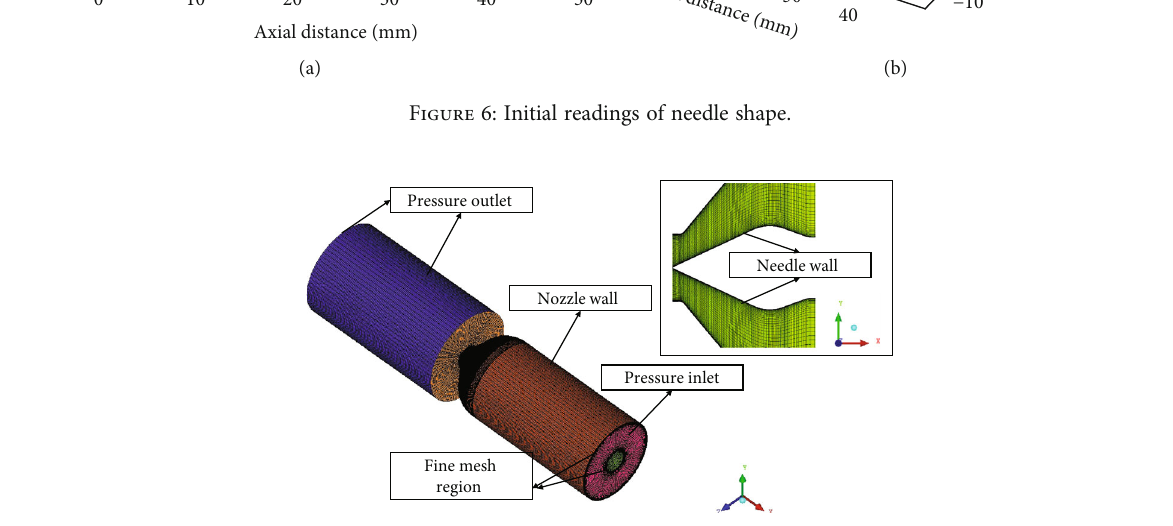
Figure 7: Mesh with in fl ation layers on walls and respective boundary conditions. Table 1: Solver settings used in ANSYS Fluent.